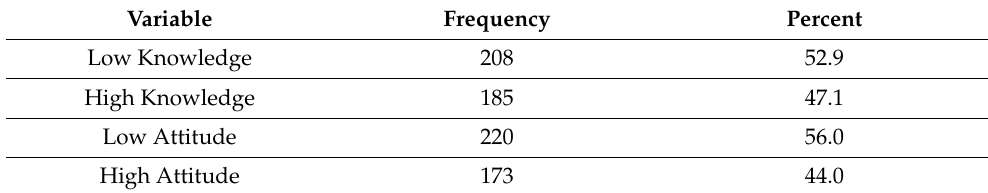
Table 5. The frequency of low and high levels. Variable Frequency Percent Low Knowledge 208 52.9 High Knowledge 185 47.1 Low Attitude 220 56.0 High Attitude 173 44.0